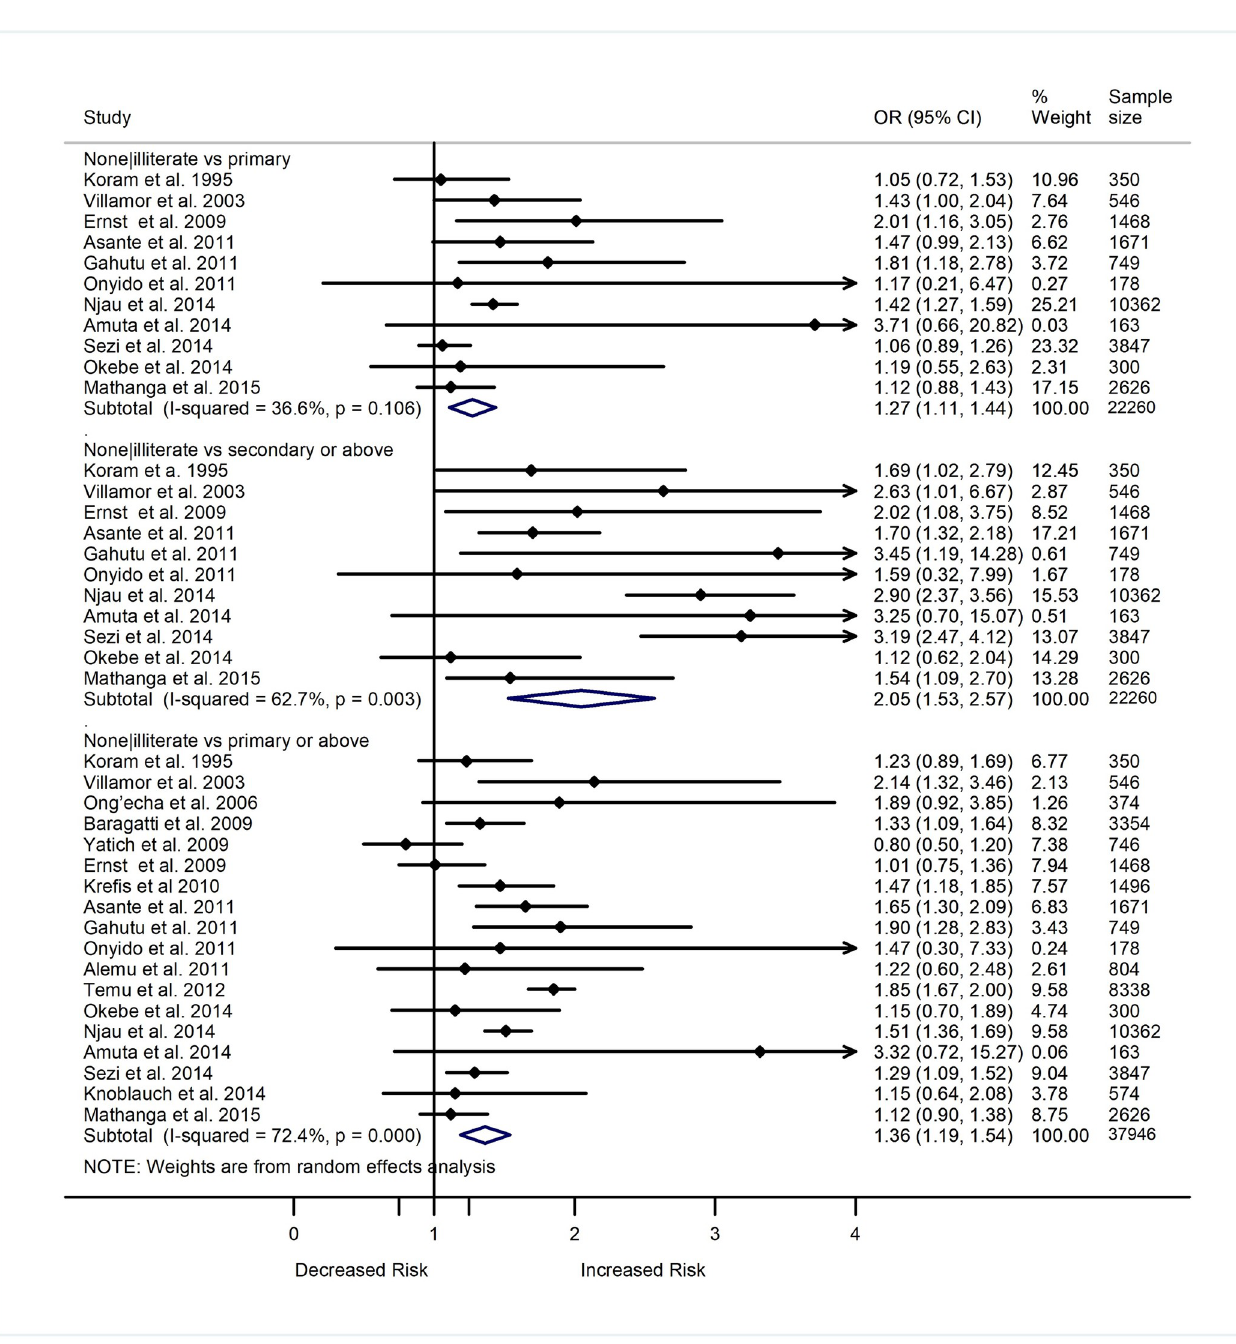
Fig 4. Forest plot comparing the odds ratio of Plasmodium infection between individuals without formal education or illiterate with those who had primary and secondary or more education level. Subtotal (summary) ORs estimated using random effect model. Weights estimated using inverse variance method. I 2 , a measure of